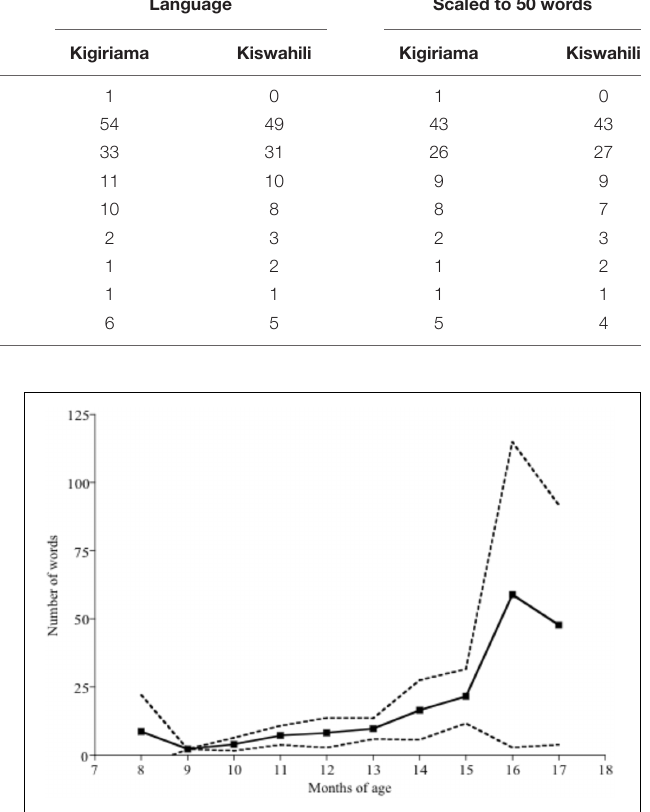
FIGURE 1 | Number of words produced by children of each age, with 95% confidence